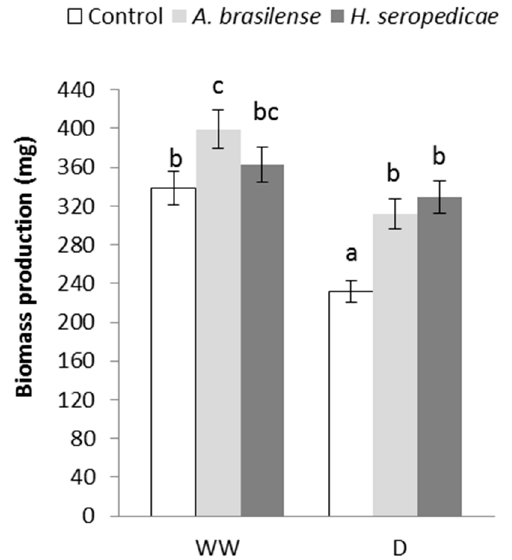
Figure 1. Total biomass production 20 days after sowing (DAS). Data are shown as means ± standard deviations (SD) ( n = 6). Means with common letters are not significantly different ( p > 0.05). The plants were cultivated under well-watered (WW) or drought (D) conditions. The inoculation * drought interaction p = 0.0213.